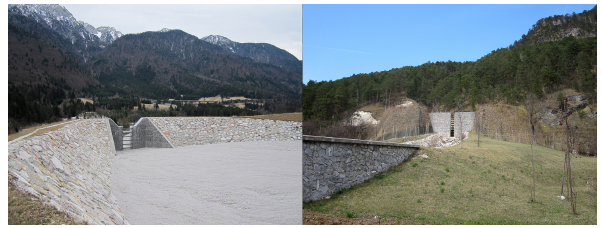
Figure 6. Structural debris flow mitigation measures in Malborghetto-Valbruna,